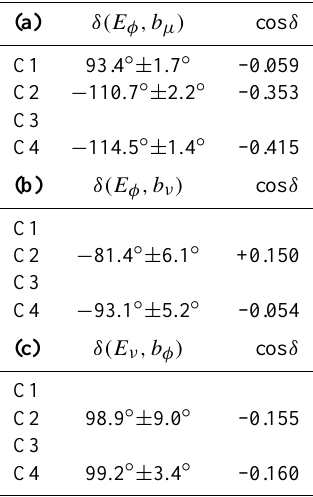
Table 2. Average phase differences between orthogonal electric and magnetic field components: (a) b µ versus E φ , (b) b ν versus E φ , (c) b φ versus E ν .